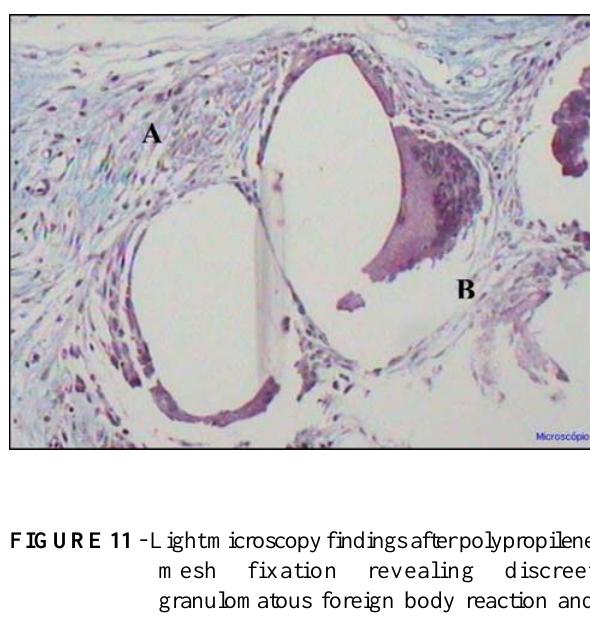
FIGURE 11 - Light microscopy findings after polypropilene